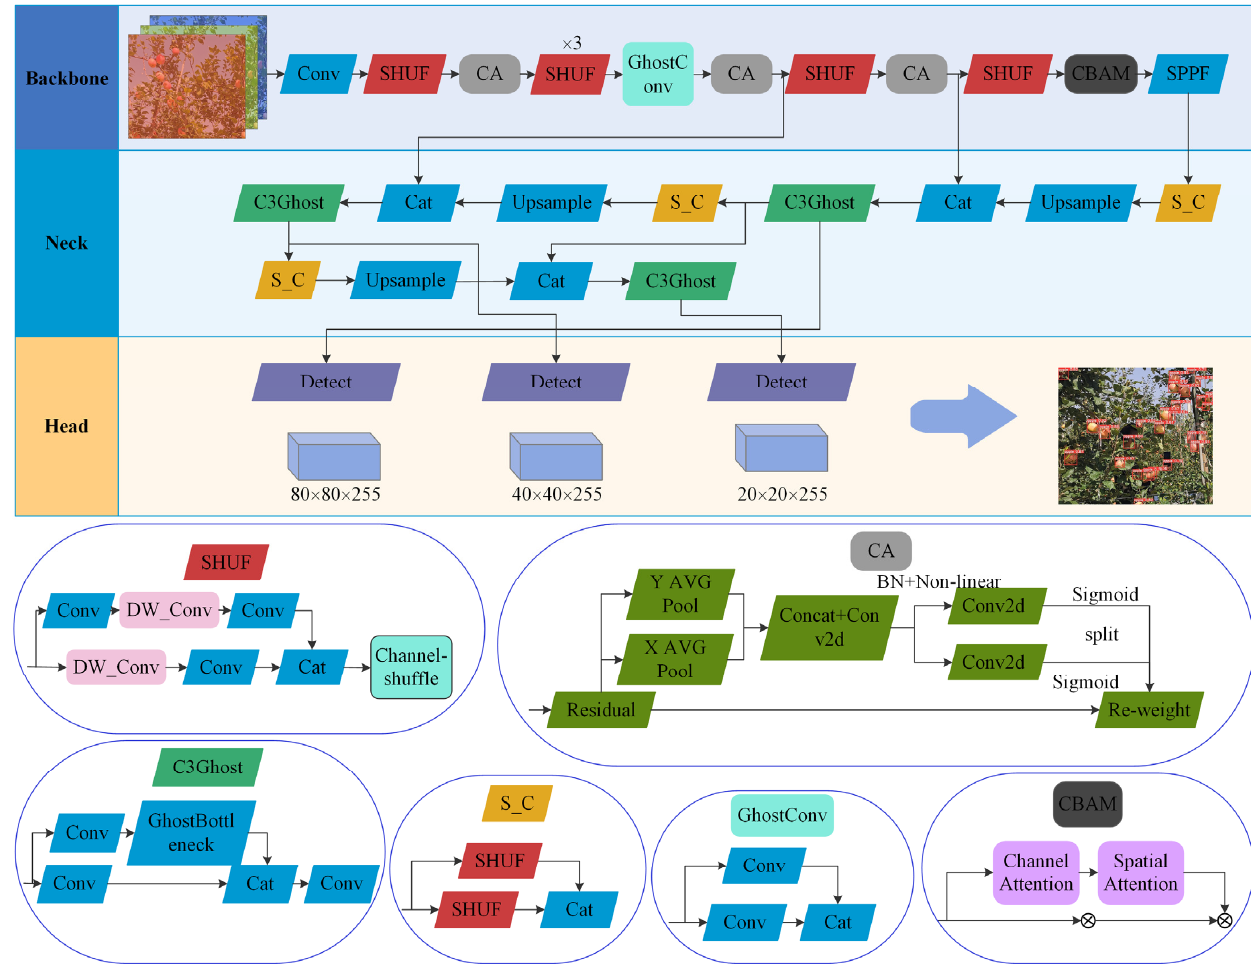
Figure 4. The architecture of the YOLOv5-PRE method.